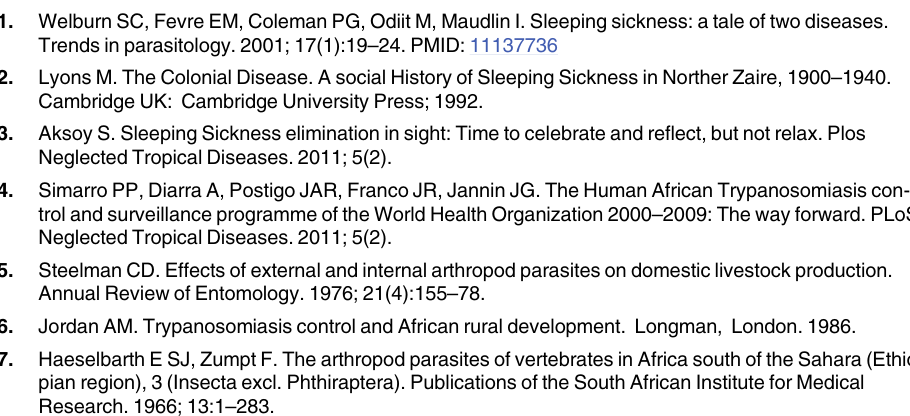
S2 Fig. Replicating experiments of the protein immunogenicity detection of the saliva from Gmm , Gpd , Gff and Gpg . The immunoblots were probed with anti- Gmm saliva antisera from different mice. (TIF) S3 Fig. Native PAGE and immunoblot analysis of saliva proteins from Gmm , Gpd and Gpg . (A) Native PAGE of saliva proteins from Gmm , Gpd and Gpg . (B) Immunoblot probed by Gmm saliva antibodies. (C) Immunoblot probed by Gff saliva antibodies. (TIF) S4 Fig. Immunoblots detecting interactions between cattle serum collected in Eastern Uganda with saliva from Gmm , Gpd , and Gpg . The blots were probed with sera from (A) calves aged 2 – 4 months from Kibuku (B) calves aged 3 – 8 months from Manafwa and (C) com- mercially available FBS. (TIF) S5 Fig. Course of the anti-TSGF antibody titer in passive-immunized mice. (A): TSGF-1 antibody titer and (B): TSGF-2 antibody titer detected by ELISA. Mouse serums were collected on Day 1 and Day 12 post antibody injection. Data were represented as Δ OD 450.